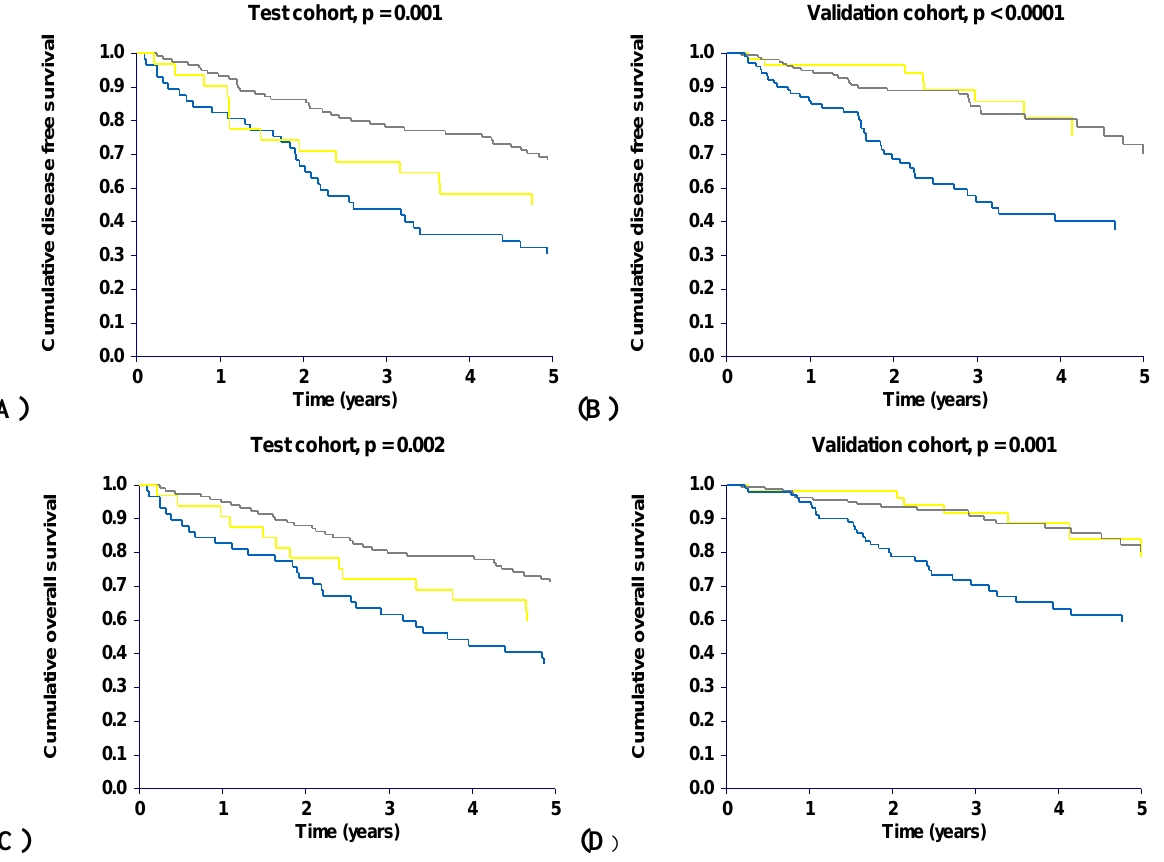
Figure 2. A to D Kaplan-Meier survival curves according to haplotype combinations. The blue line represents patients with the (CTC, ACG) haplotype combination and the yellow line patients with the (CTG, ACG) combination. Patients with the remaining four haplotype combinations are represented by a single grey line. All patients from both cohorts are included.